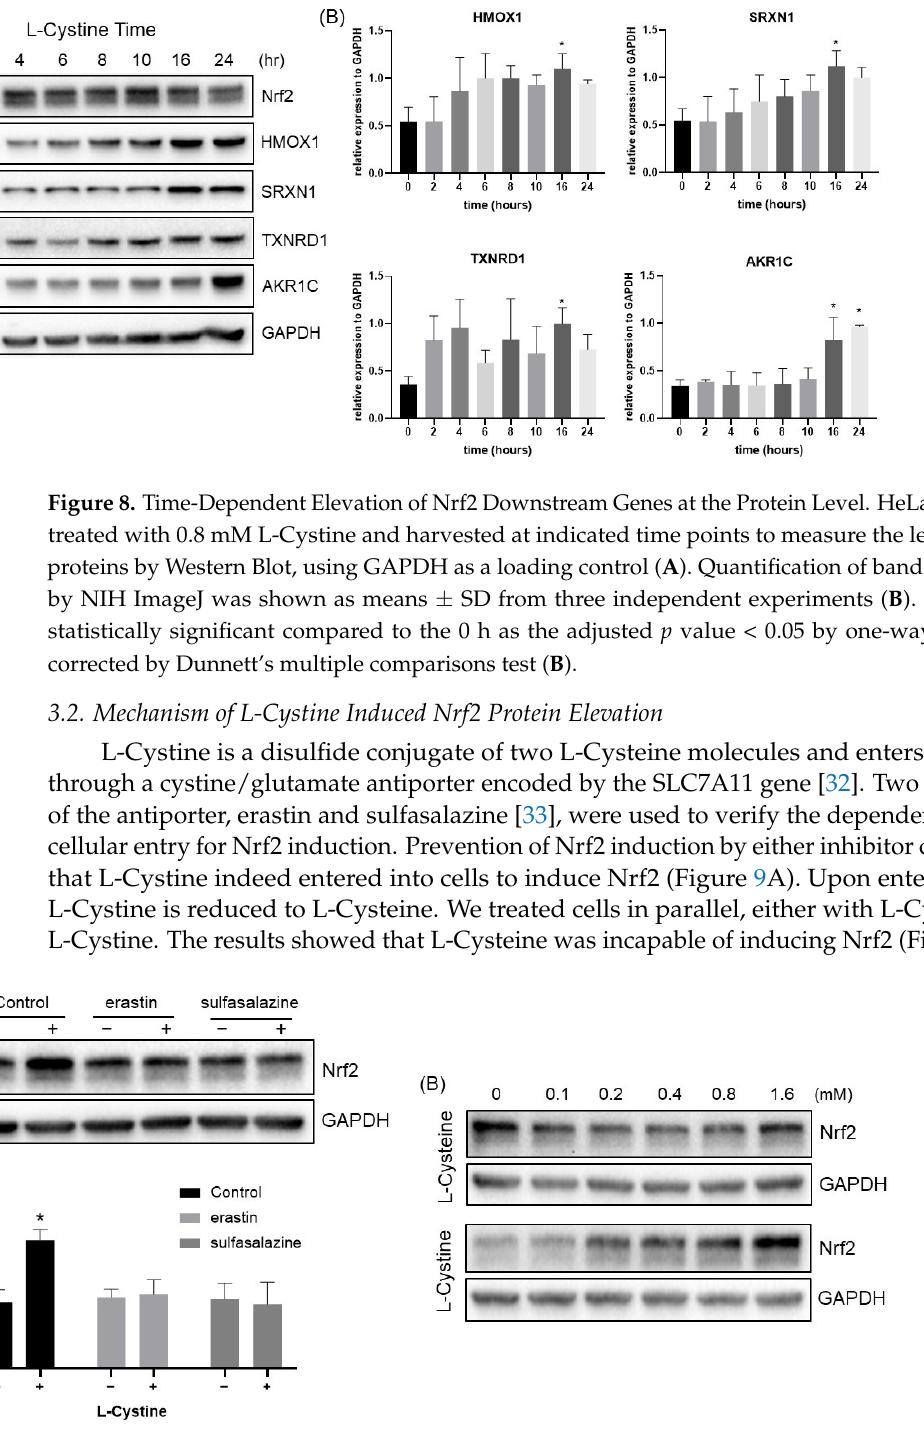
Figure 9. Inhibitors of Cystine/Glutamate Antiporter Block L-Cystine from Inducing Nrf2 Protein. HeLa cells at 2 days after subculture were treated with 5 µ M erastin or 500 µ M sulfasalazine for 24 h before treatment with 0.8 mM L-Cystine for 4 h ( A ). At day 3 after subculture, HeLa cells were treated with L-Cysteine or L-Cystine in parallel at the indicated doses for 4 h ( B ). Cells were harvested to measure Nrf2 protein levels by Western Blot, using GAPDH as a loading control. Quantification of Nrf2 over GAPDH protein band intensities by NIH ImageJ is shown as means ± SD from three independent experiments. * indicates statistically significant from the control group without L-Cystine treatment as the adjusted p value < 0.05 compared to the control by two-way ANOVA, corrected by Turkey’s multiple comparisons test ( A ).